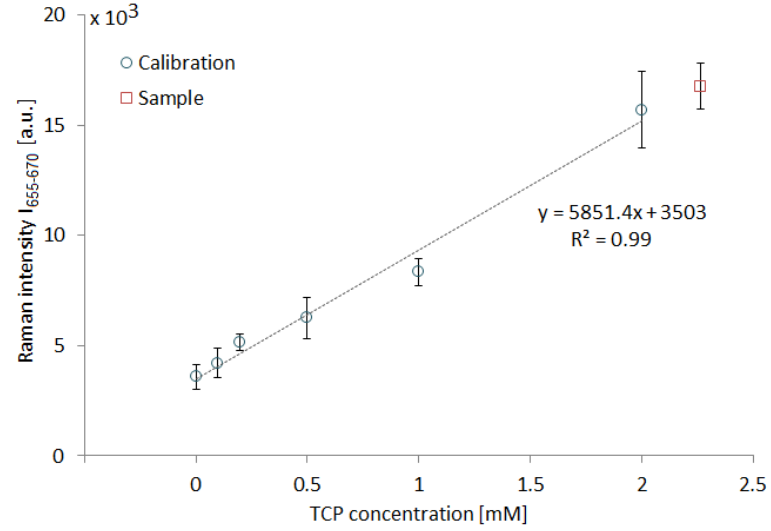
Figure 11. SERS of TCP on SK307 substrate: TCP calibration series (blue circles) and a separately injected sample (red square) of TCP solution (2 mM). Raman intensity I 655–670 (vertical axis) represents